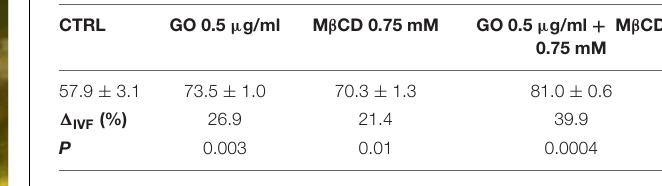
TABLE 4 | Data summarizing the IVF outcome, expressed as the difference in percentage change ( (cid:49) IVF%) of the fertilization rates in experiments carried out with spermatozoa exposed to GO (0.5 µ g/ml) and/or M β CD 0.75 mM respect to the